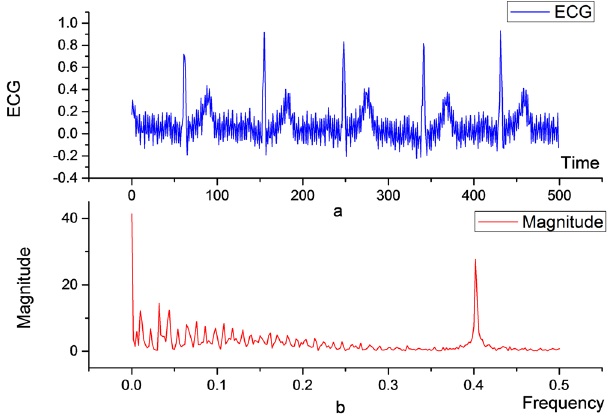
Figure 7. ECG signal with high frequency noise and its frequency